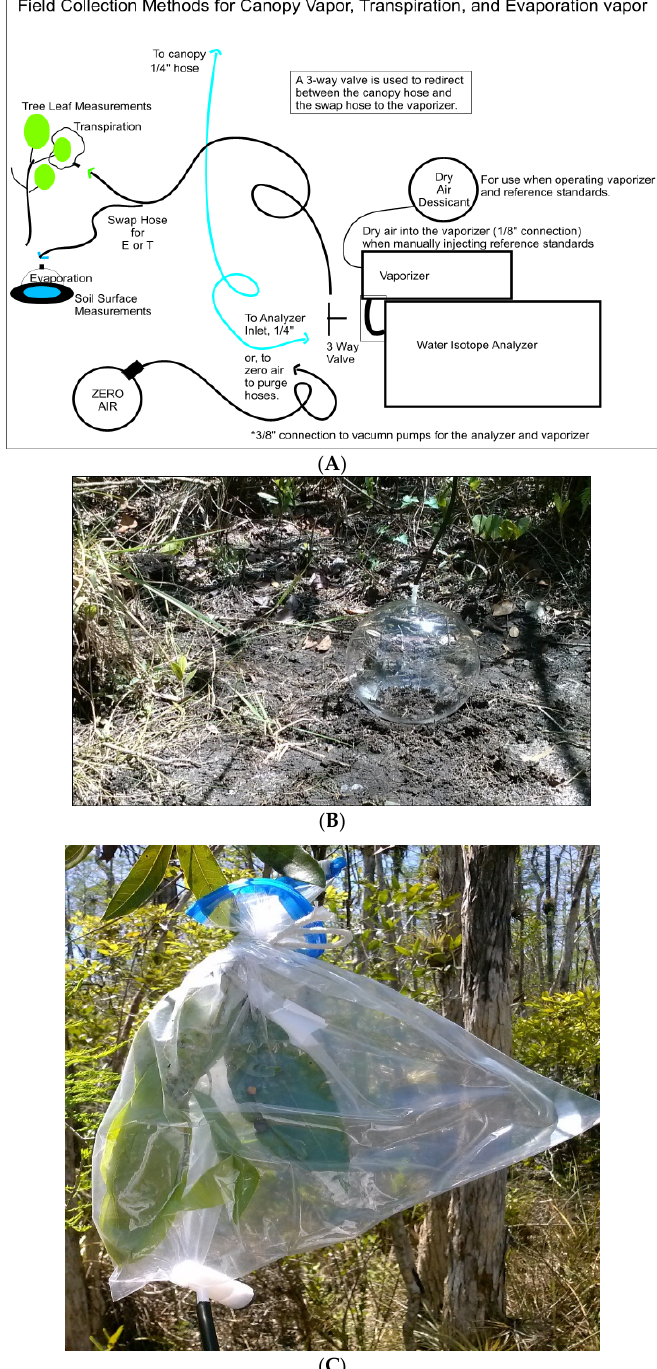
Figure 3. ( A ) Illustration of field experimentation. ( B ) Evaporation collection dome. ( C ) Transpiration collection bag.